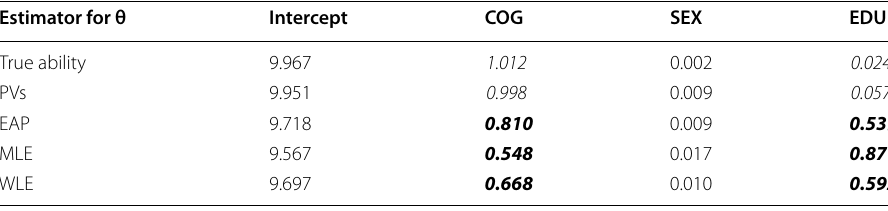
Table 1 Estimated regression coefficients for a model predicting wages (raw) based on skill variable theta (either true value, or PVs, or WLE, MLE, EAP estimates), gender and